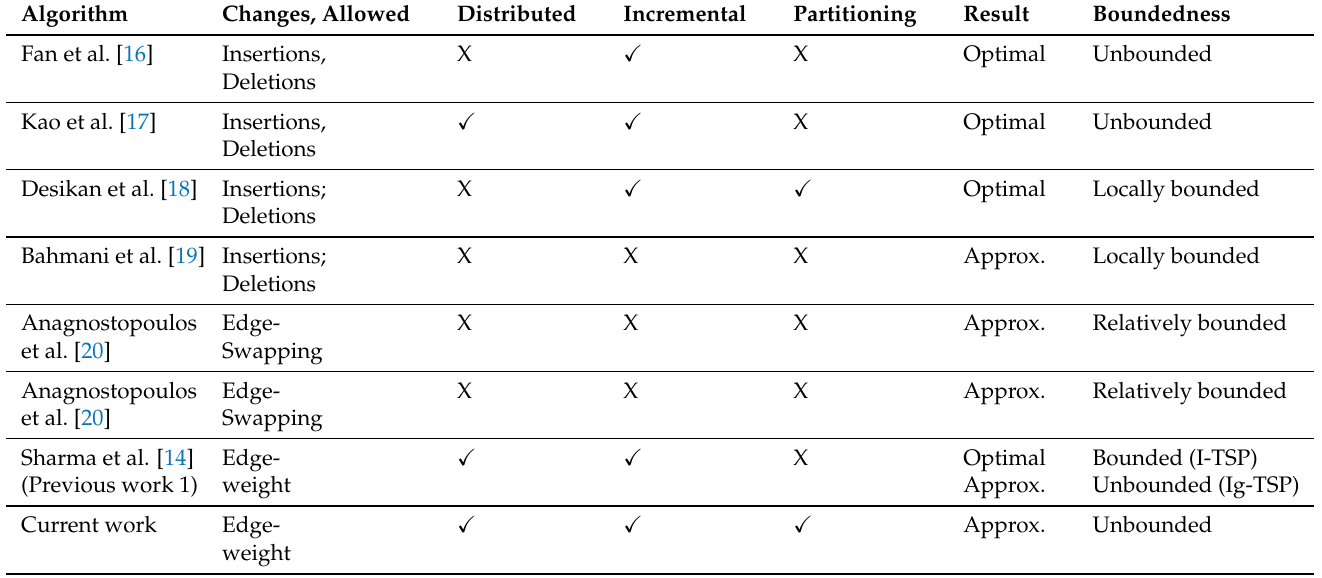
Table 1. Comparing state-of-the-art algorithms on the basis of approach used in implementation for TEG with this research work. The approach used is marked by (cid:88) and approach not used is marked by